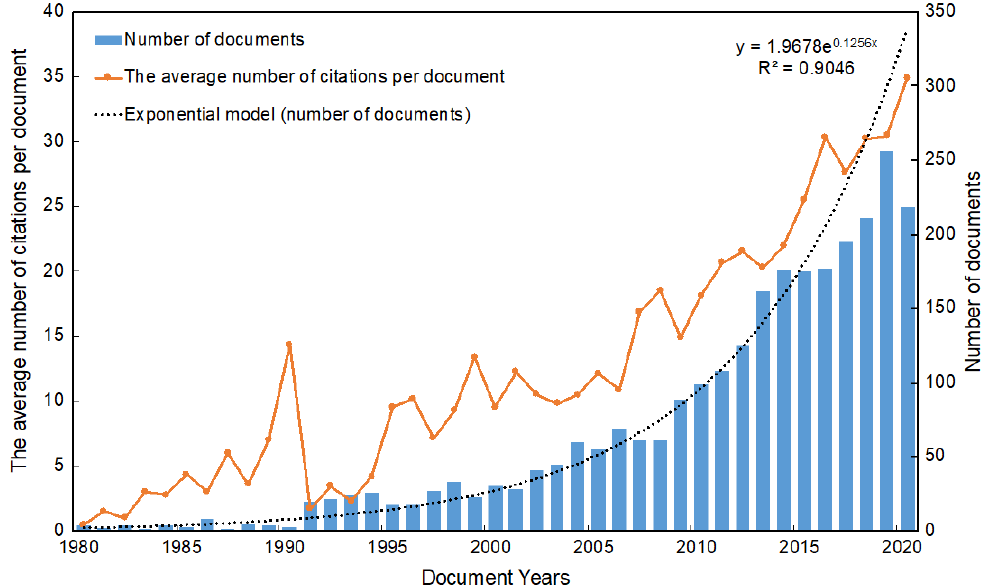
Figure 1. Temporal evolution of documents on grassland remote sensing (GRS) research from 1980 to 2020. Table 1. Basic information of datasets.